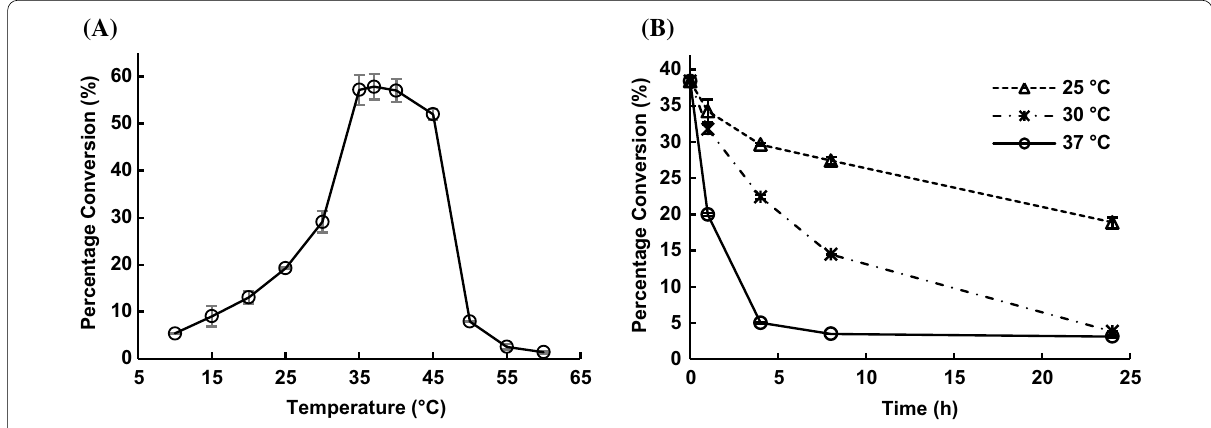
Fig. 6 Temperature profiles ( A ) and thermostability ( B ) of